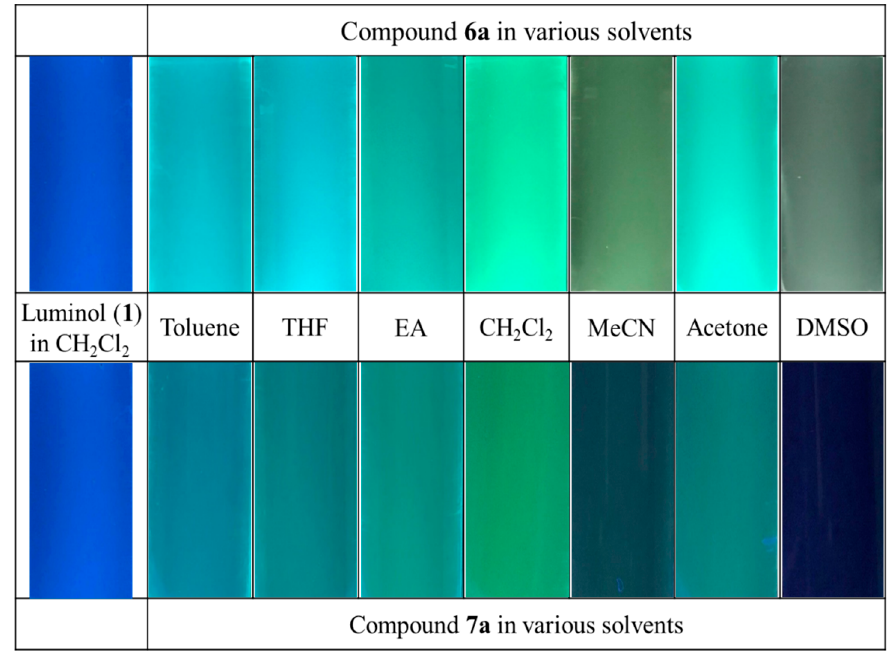
Figure 4. Color pictures of the fluorescence of compounds 6a and 7a in various solvents under excitation at 365 nm.